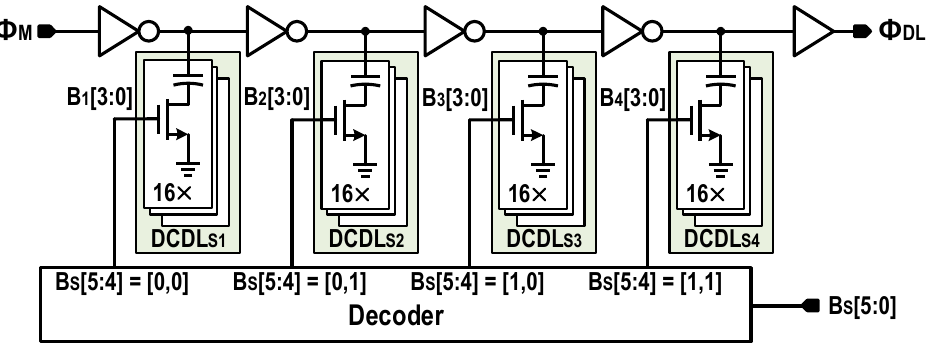
Figure 10. Block diagram of 6-bit DCDL. Table 1. Truth table of